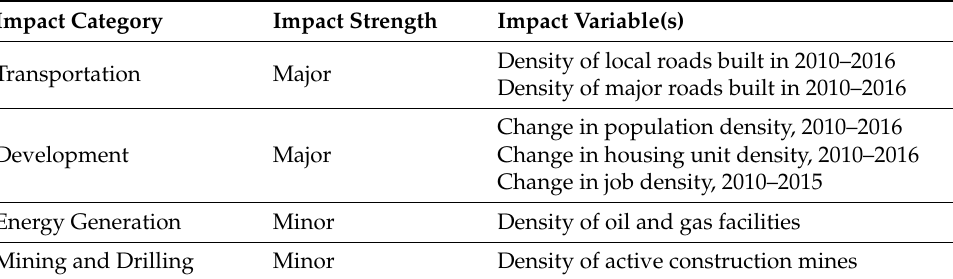
Table A2. Characterizing current demand for stream mitigation based on